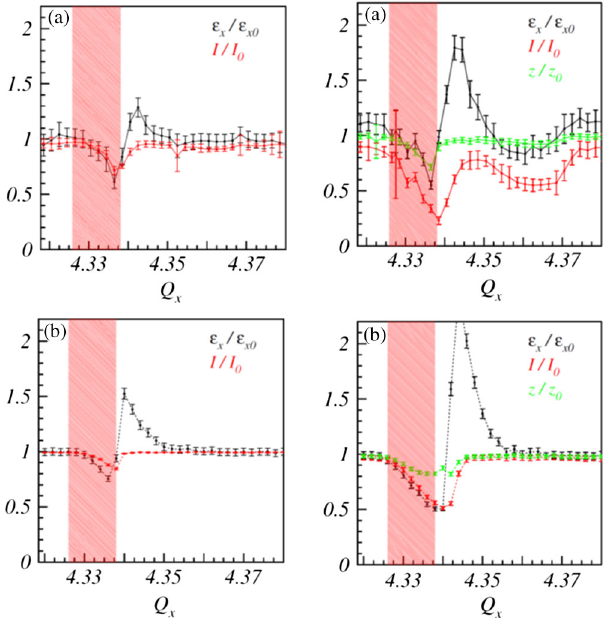
FIG. 1. Results of SIS18 measurements (a) and frozen space charge (FSM) simulations (b) near a sextupole error resonance at Q ≈ 4 . 33 after 10 5 turns. The comparison is in support of x incoherent resonance response for a coasting beam (left column) as well as for a bunched beam (right column). Maximum incoherent tuneshifts in x are − 0 . 025 for the coasting, and − 0 . 04 for the bunched beam. Shown are relative changes of rms emittances and current versus the bare tune Q x , furthermore the length change for the bunched beam. Source: Ref.